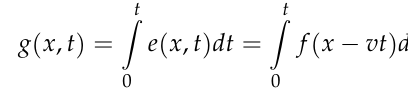
where e ( x , t ) is the exposure of the camera at time t ; when t=0 , it is expressed as f(x) , then it can be defined as e(x,t) = f(x − vt) at any time t . The image acquired on the image sensor at this time is the cumulative exposure at that moment, expressed as: